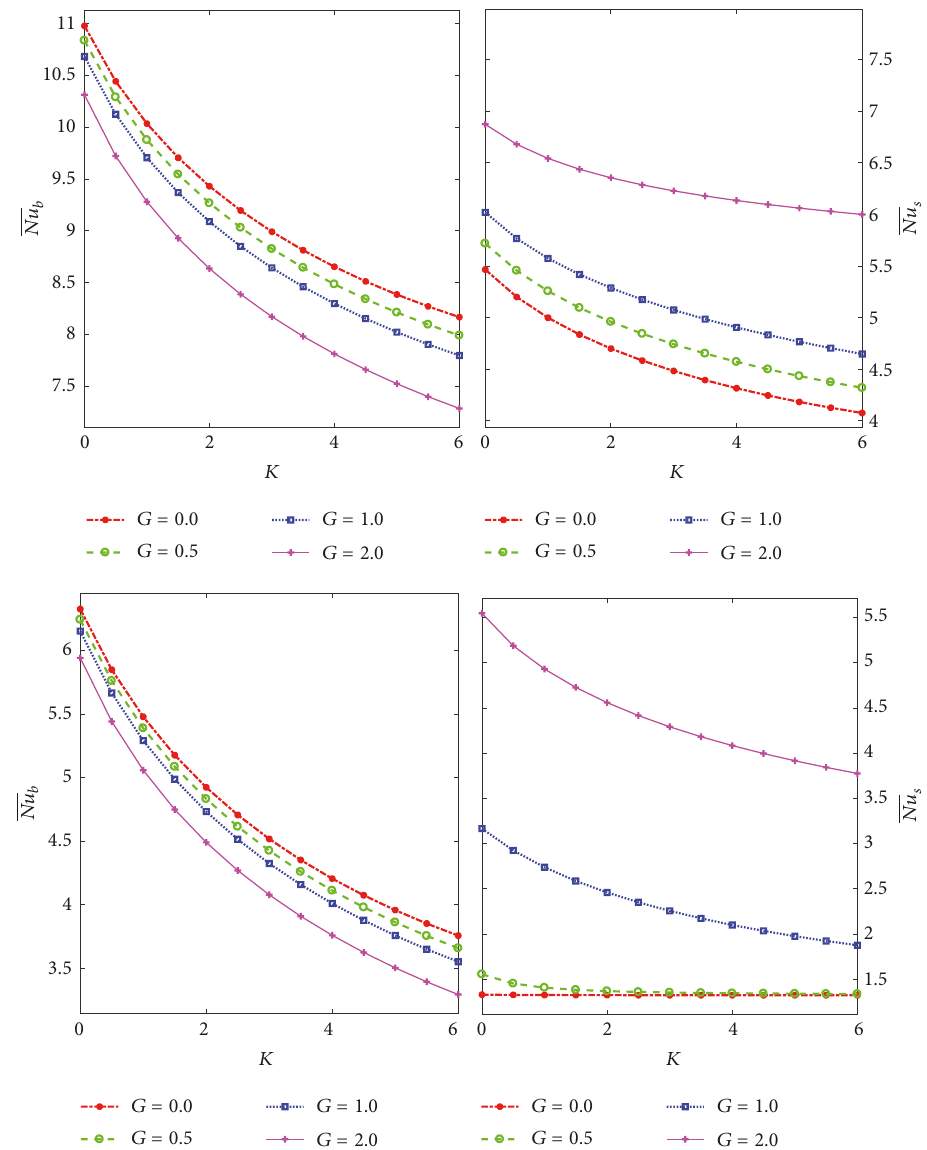
Figure 7: Variations of average Nusselt number at bottom (left) and average Nusselt number at side (right) against K by varying 𝜙 for continuous case 1 (top) and discontinuous heating case 2 (bottom) at 𝐺 = 1.0